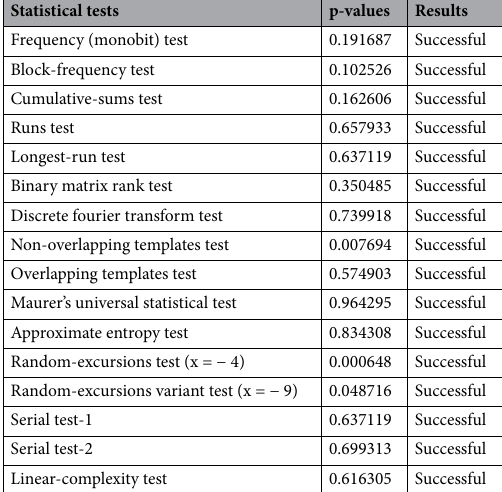
Table 1. NIST-800-22 test results.